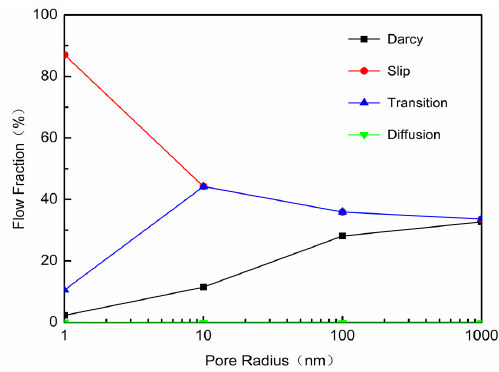
Figure 2. Gas flow fraction versus pore radius.